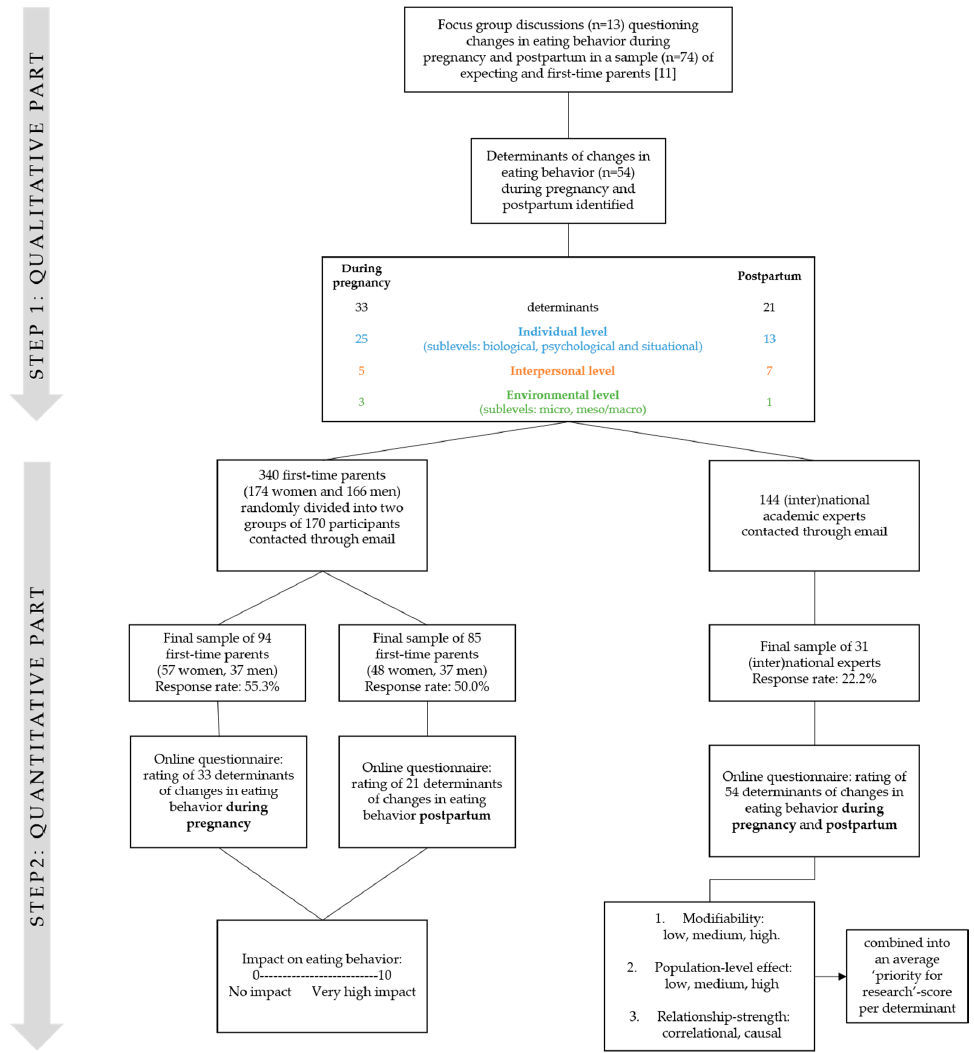
Figure 1. Flowchart of the study methodology and participant